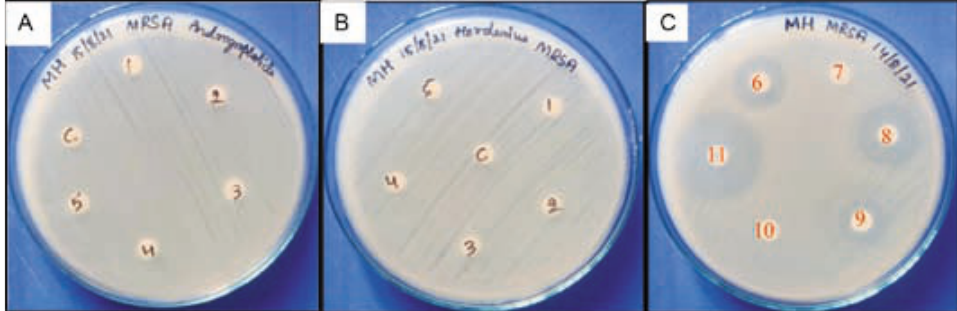
Fig. 1. In vitro antibacterial activity of (A) andrographolide and (B) hordenine (C) antibiotics against MRSA: C- control, 1-1000 µg/mL, 2- 500 µg/mL, 3- 250 µg/mL, 4- 125 µg/mL, 5- 62.5 µg/mL,6- Cefoxitin, 7- Oxacillin,